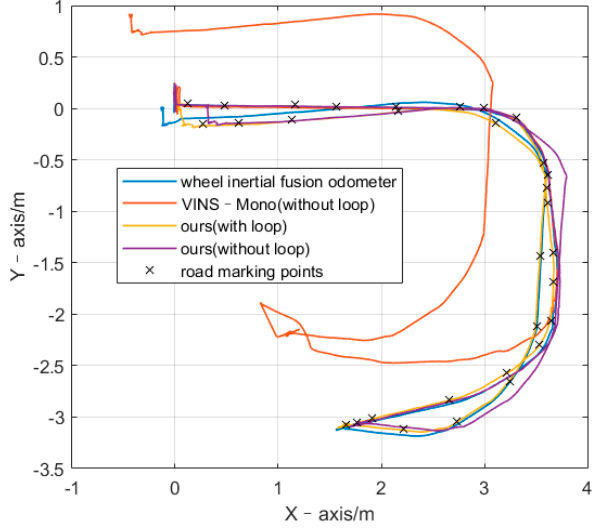
Figure 7. Path while visual tracking is failed. Table 3. Pose measurement results when visual tracking was lost.